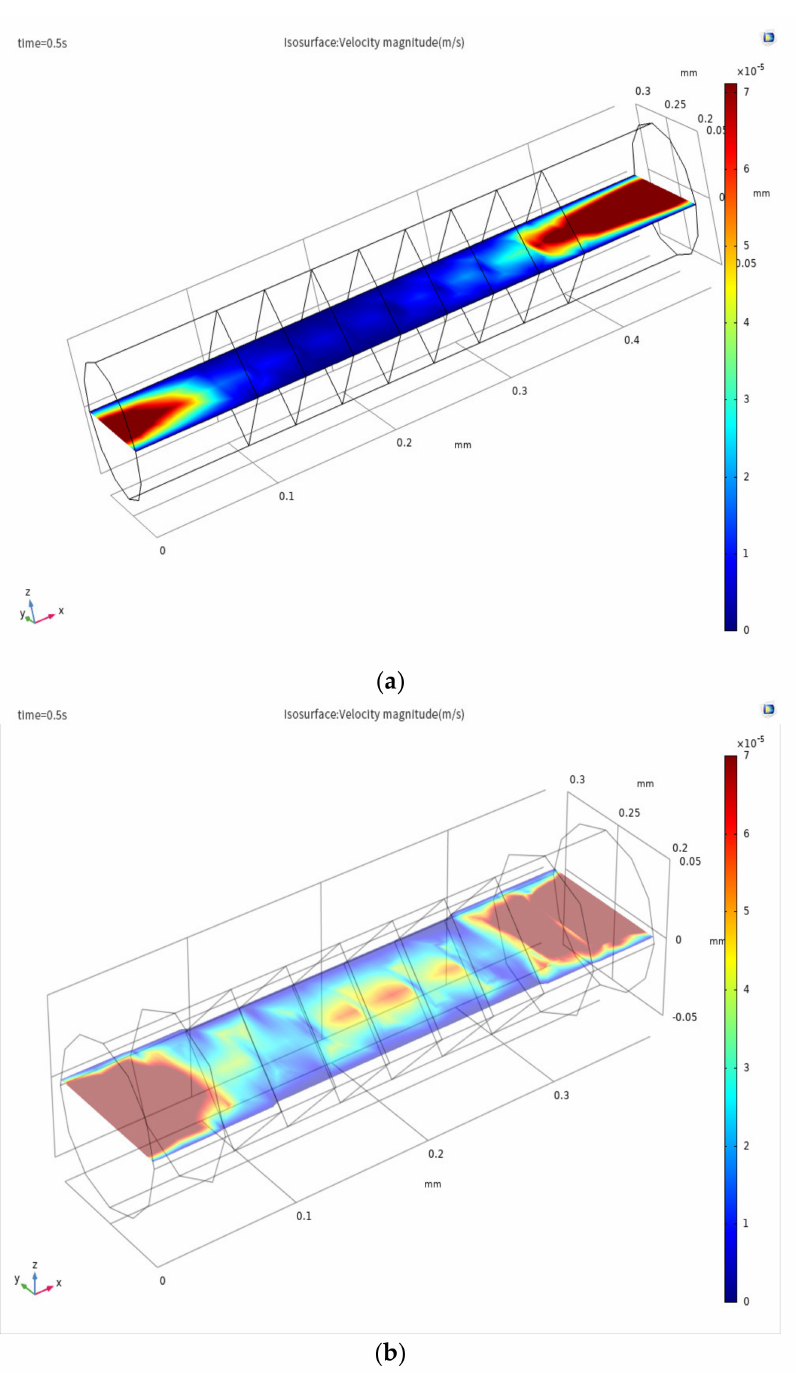
Figure 5. Axial velocity field distribution of the xy plane in the sensing element when the thickness of the outermost insulation layers is ( a ) 100 µ m and ( b ) 50 µ